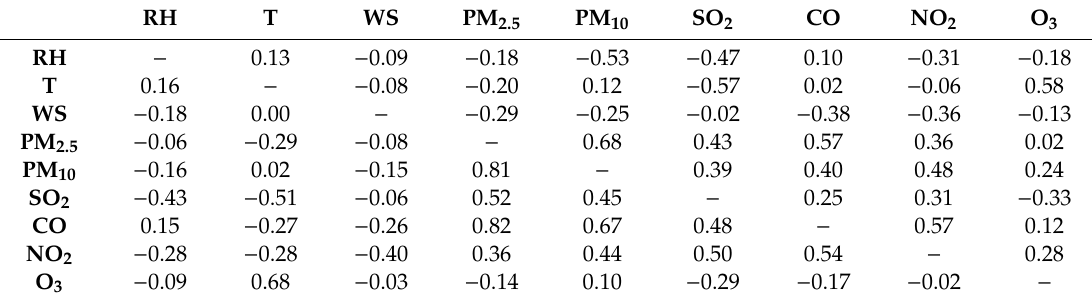
Table 4. The Pearson Correlations between six pollutants and meteorological elements (RH: relative humidity; T: temperature; WS: wind speed) in the non-episode days (cells above the diagonal) and episode days (cells below the